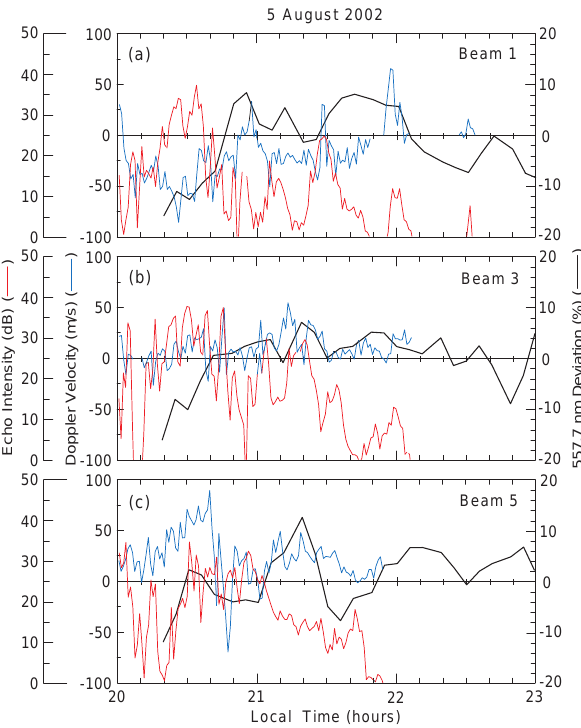
Fig. 7. Temporal variations of echo intensity, Doppler velocity, and deviation of 557.7-nm airglow intensity ( 1I 558 ) at around 96km altitude (white circles in Fig. 1) on beams 1, 3 and 5.